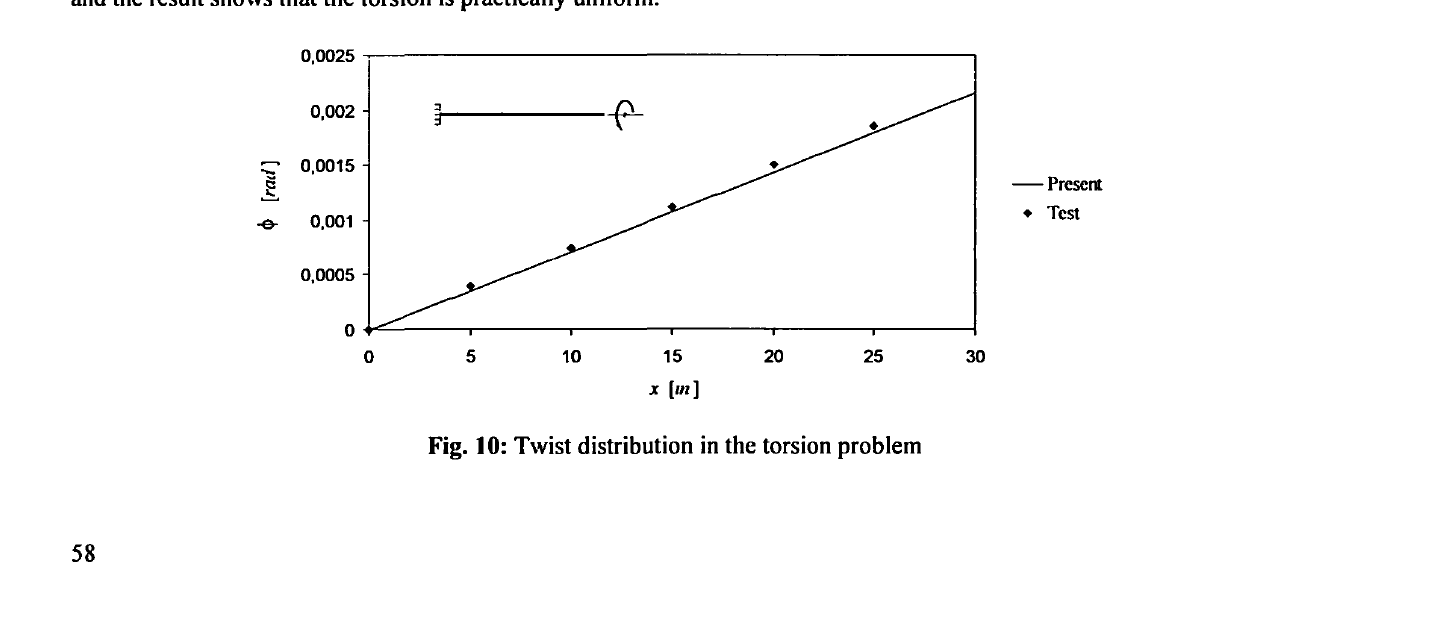
Fig. 9: Twist distribution in the bending problem